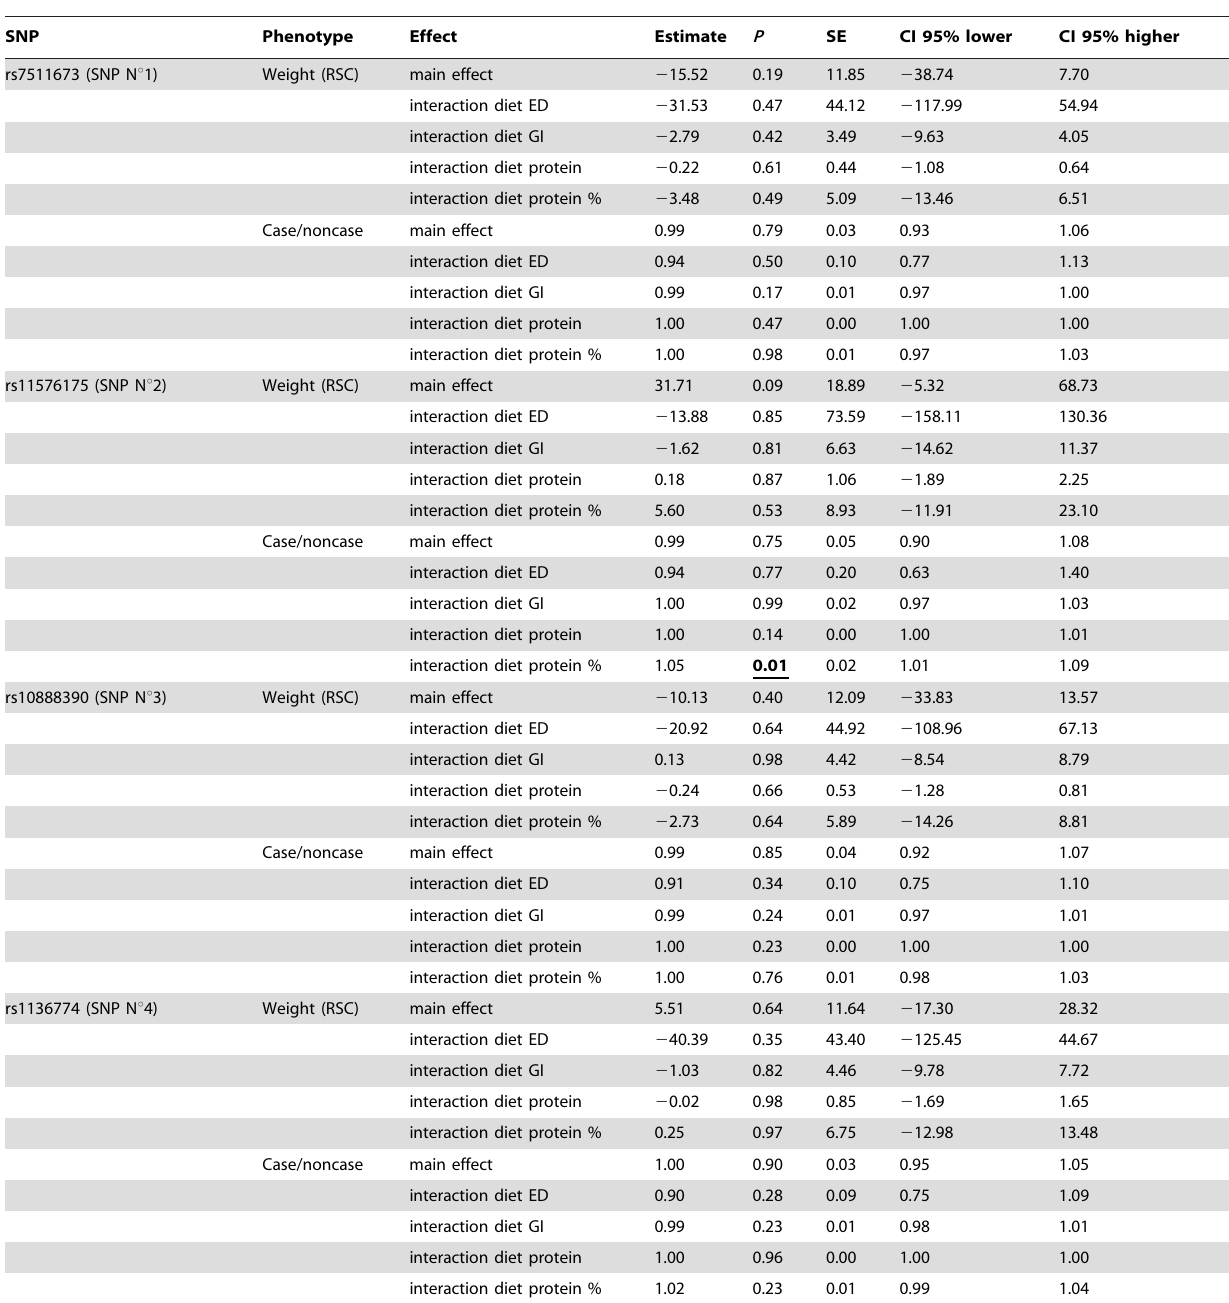
Table 4. Association between CTSS SNPs and weight change during the study.